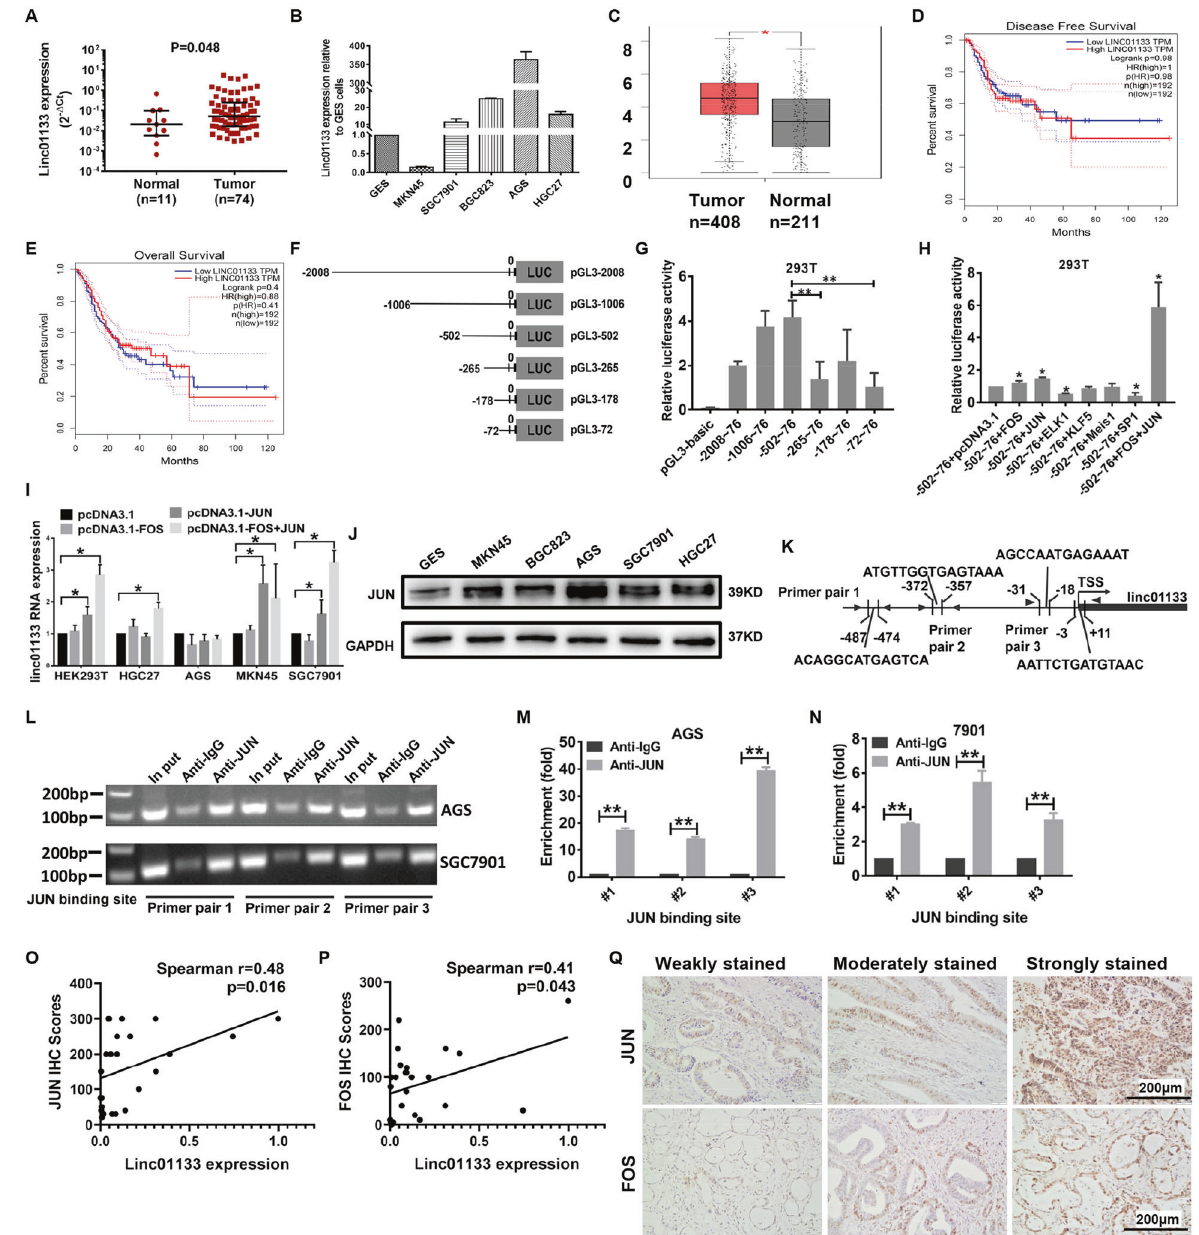
Fig. 1 Relative expression of linc01133 in gastric cancer tissue. A RT-qPCR showed that linc01133 expression was upregulated in gastric cancer tissues compared to that in the normal gastric tissues (Mann – Whitney test, p = 0.048). B The expression of linc01133 was upregulated in gastric cancer cells compared to the immortalized normal gastric epithelial cells. C Online tool GEPIA analysis of linc01133 expression combining the TCGA and GTEx database. D , E GEPIA analysis of disease-free survival and overall survival of gastric patients with high ( n = 192) and low ( n = 192) linc01133 expression. F Schematic illustration of the luciferase vectors containing linc01133 promoter regions. G Luciferase assay con fi ned the core regulatory regions to − 502~ − 265 bp and − 72~ + 76 bp up-stream of transcriptional start site. H Luciferase assay showed that co-expression of c-JUN and c-FOS signi fi cantly increased the pGL3-502 luciferase activity. I Co-expression of c-JUN and c-FOS enhanced linc01133 expression in HEK293T, HGC27, MKN45 and SGC7901 cells but not in AGS cells. J JUN expression in gastric cancer cell lines. K Schematic illustration of the c-JUN-binding sites and the sites of primer pair design for ChIP assay. L – N ChIP-qPCR analyses showed that the promoter amplicons in the JUN-binding sites were signi fi cantly enriched by anti-Jun antibody. O , P The expression of Linc01133 was positively correlated with that of c-JUN and c-FOS in gastric cancer tissues ( n = 25). Q Representative staining patterns of c-Jun and c-FOS detected by immunohistochemistry in gastric cancer tissues. Each experiment was performed in triplicates. Data are shown as mean ± SD, * P < 0.05, ** P < 0.01. increased in four out of the fi ve gastric cancer cell lines examined normal gastric tissues ( P = 0.048, Fig. 1A). The relationship compared to the immortalized normal gastric epithelial cell GES-1 between linc01133 expression and clinicopathological character- (Fig. 1B). An online tool GEPIA combining the TCGA data and GTEx istics was also analyzed (Table 1). The expression of linc01133 was data was utilized to further analyze the expression of linc01133 in positively related with tumor size ( p = 0.03) and differentiation ( p = 0.003). Furthermore, linc01133 expression was signi fi cantly gastric cancer tissue and matched normal tissue. Similar as we had Cell Death and Disease (2022)